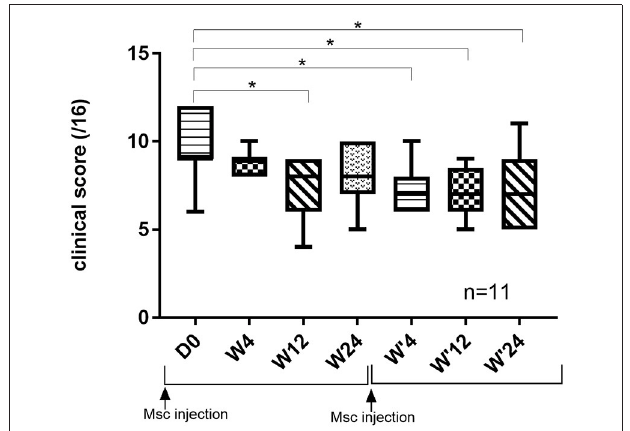
FIGURE 4 | Evolution of clinical score of joints re-injected over 12 months. * Significant difference ( p < 0.05) between the different time points and day 0.